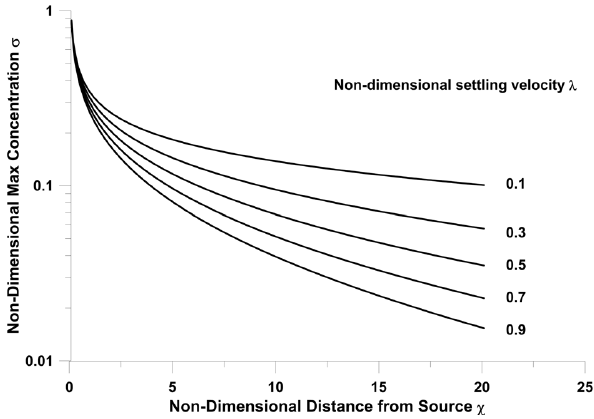
Fig. 4. Non-dimensional maximum concentration at a particu- lar location away from a pollution release as a function of non- dimensional distance and fall